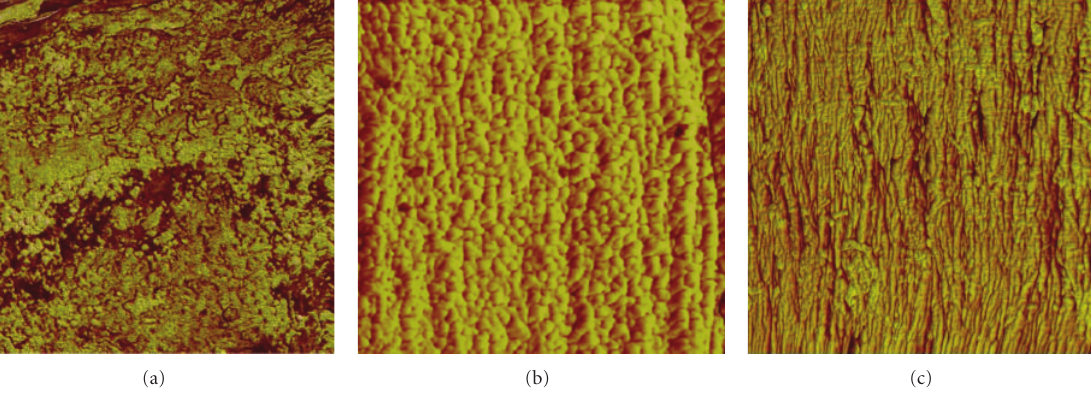
Figure 2: TM-AFM phase images (scan size of 4 μ m 2 ) of (a) raw-, (b) 5% NaOH-, and (c) 10% NaOH-treated flax